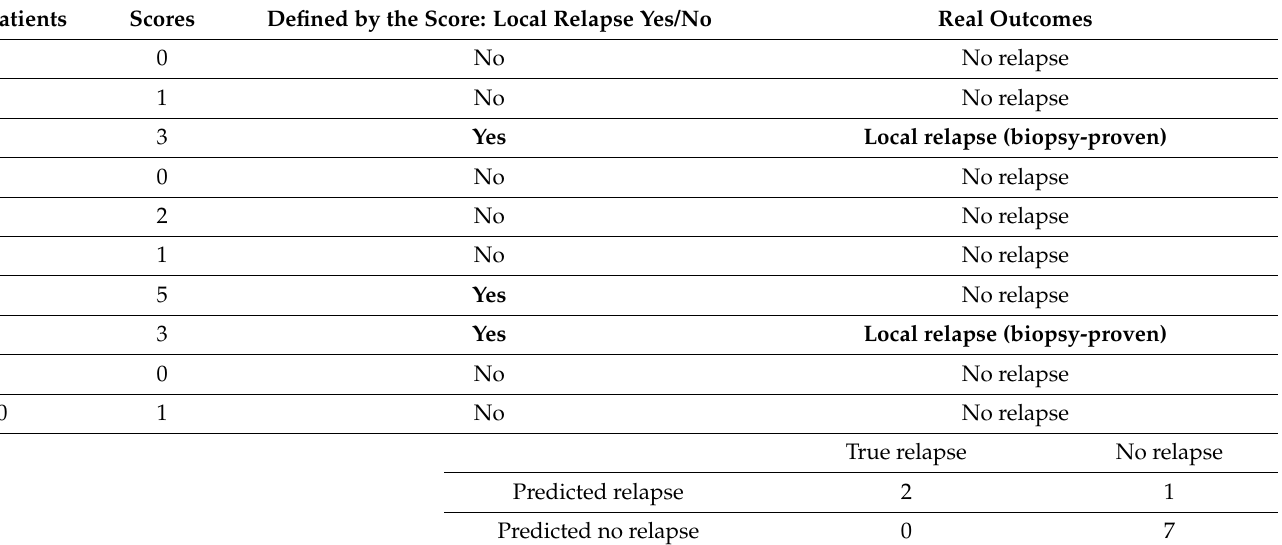
Figure 4. Importance of each variable in the score derived from a Random Forest model. The threshold was then tested on the independent validation cohort of ten patients. The score results for each patient of the validation cohort and the matrix of confusion are presented in Table 3. On this validation cohort, the sensitivity and specificity were 100% and 88%, respectively. Table 3. Score results for each patient in the validation cohort and confusion matrix.